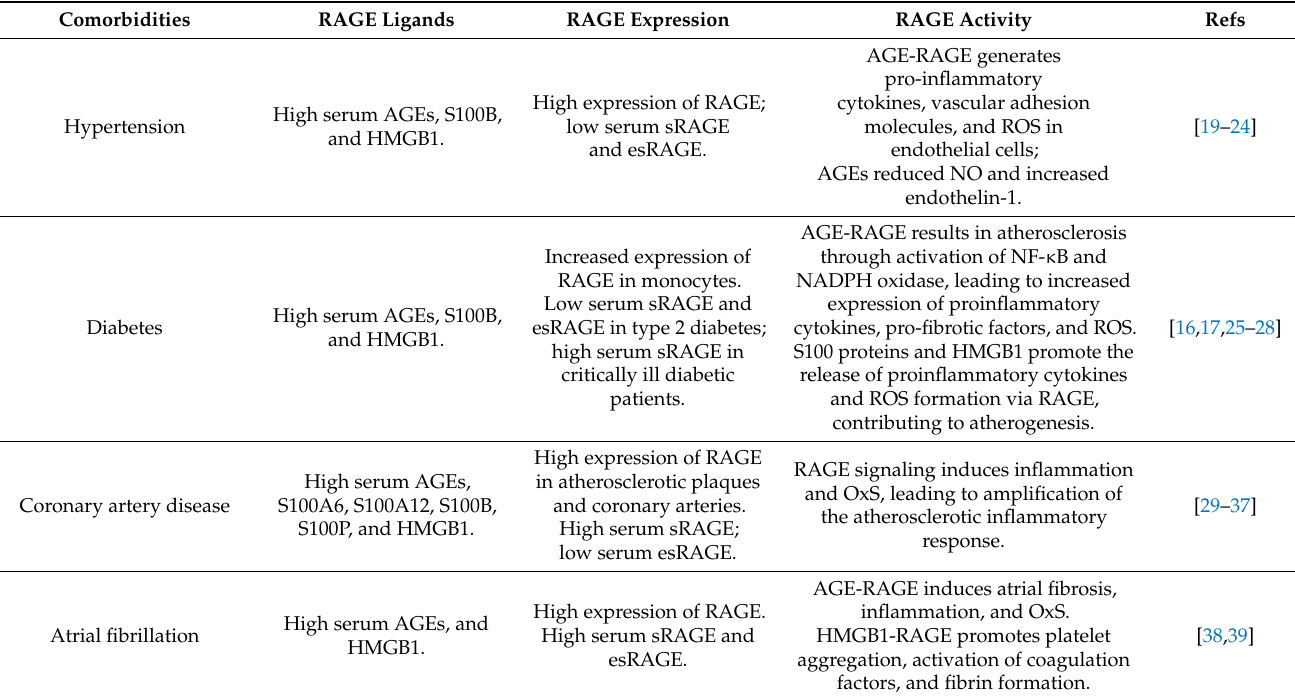
Table 2. RAGE ligands and RAGE expression and activity in COVID-19